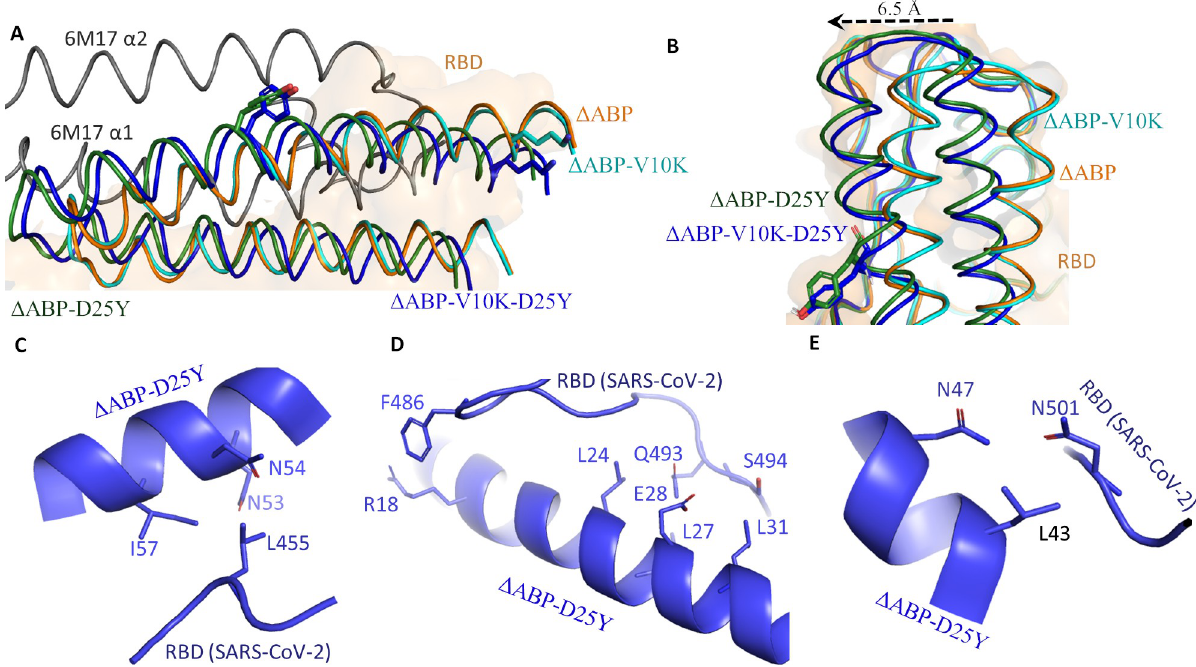
Fig 4. Interaction of Δ ABP-D25Y with SARS-CoV-2 RBD. A) HADDOCK results show that all Δ ABP peptides bind at the RBM site of the coronavirus S proteins. The α 1/ α 2 helices of Δ ABP interact with RBD whereas only α 1 of human ACE2 binds with RBD. B) The mutant inhibitors Δ ABP-D25Y and Δ ABP-V10K-D25Y are shifted laterally. Specific RBD amino acids C) Leu455, D) F486, Gln493 and Ser494 E) Asn501 interactions with Δ ABP-D25Y. https://doi.org/10.1371/journal.pone.0240004.g004 score and binding affinity for RBD (Table 2). Interaction of Δ ABP-D25Y with SARS-CoV-2 RBD (S1 File) is discussed below.